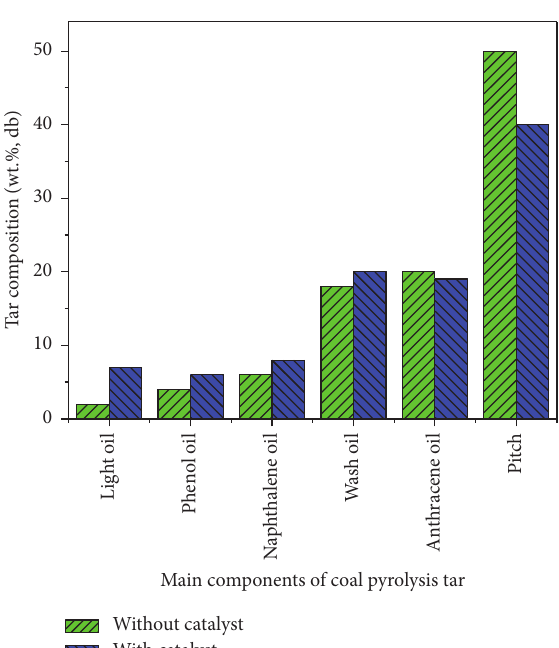
Figure 7: Tar composition of coal without and with catalyst.